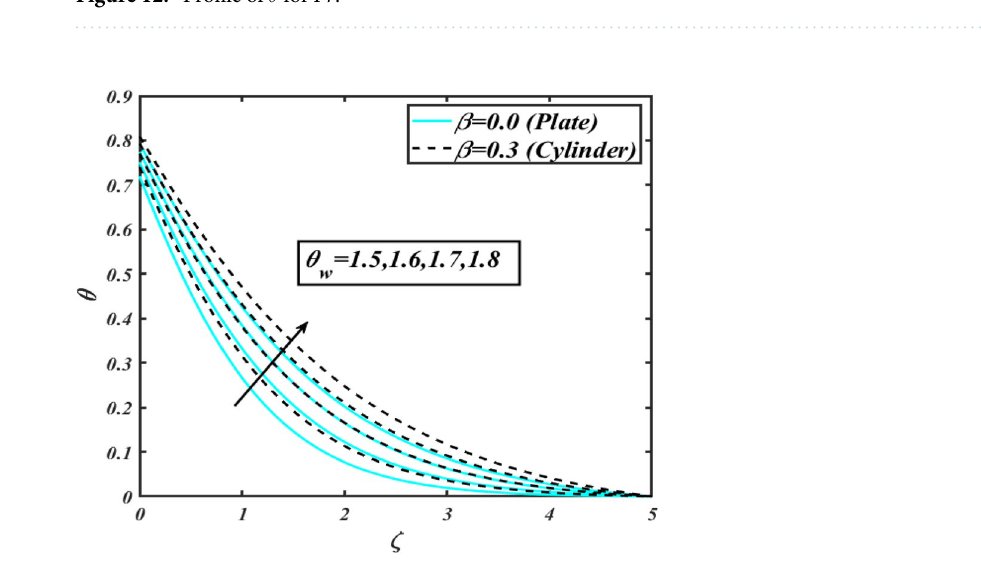
Figure 13. Profile of θ for θ w